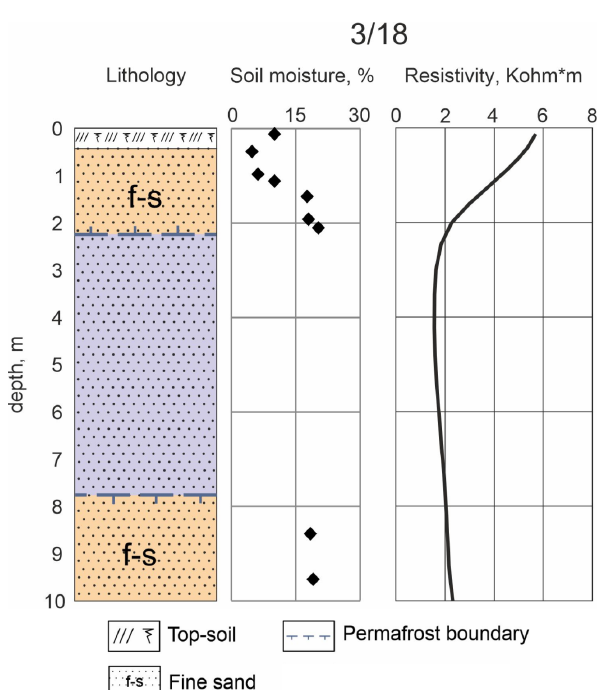
Figure 6. Results of measurements in well 3/18 – the lithology, soil moisture and resistivity are displayed from left to right. The drilling and investigations were conducted in April 2018. The blue area in the lithology section marks the unfrozen talik between the frozen areas displayed in